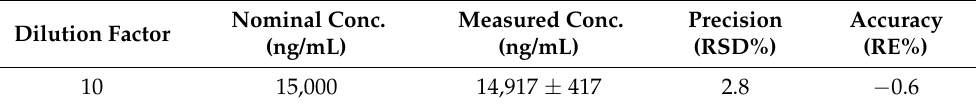
Table 7. Dilution integrity for quantification of PF in SD rat plasma ( n =